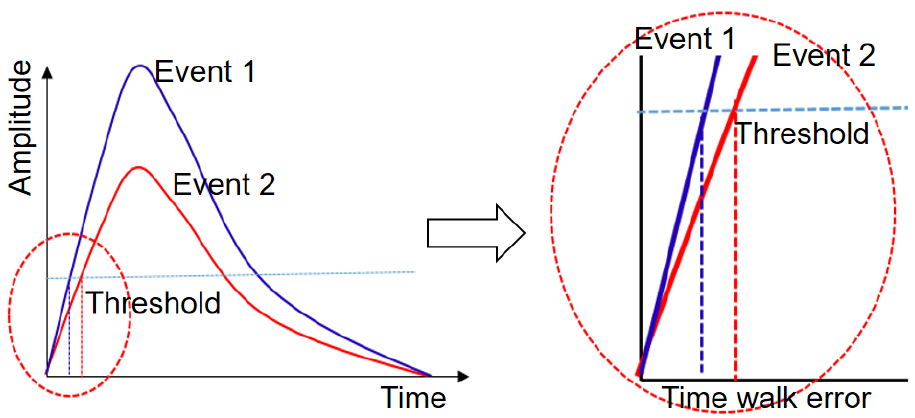
Figure 5. Schematic diagram of the time – walk for the LED trigger.